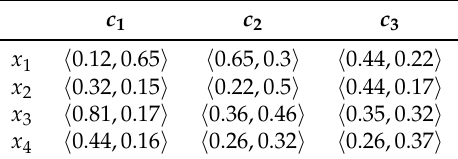
Table 2. R 2 : opinion of expert m 2 .